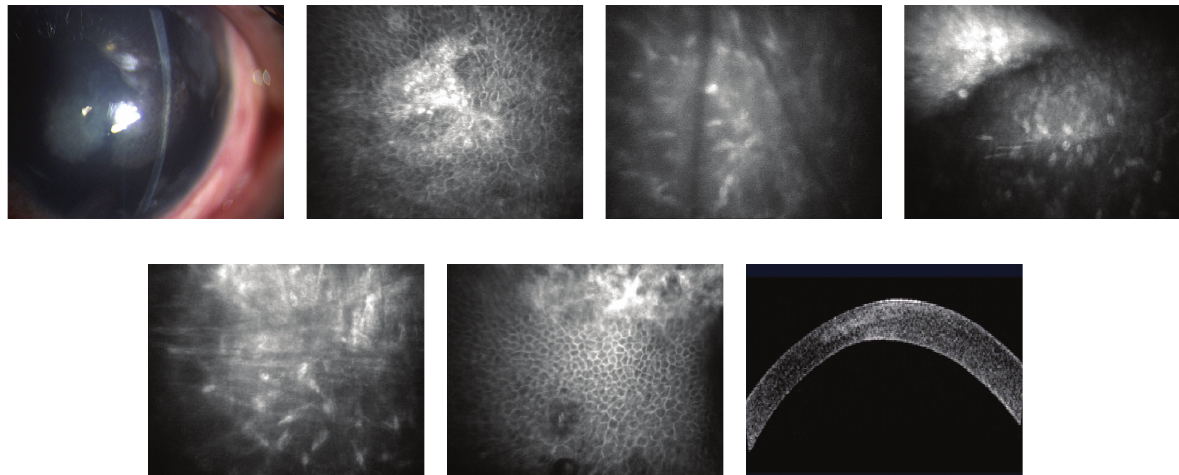
Figure 5: Traumatic corneal edema with central scarring three months after blast exposure. Epithelial scarring, Descemet’s membrane folds, endothelial scar, and stromal edema and